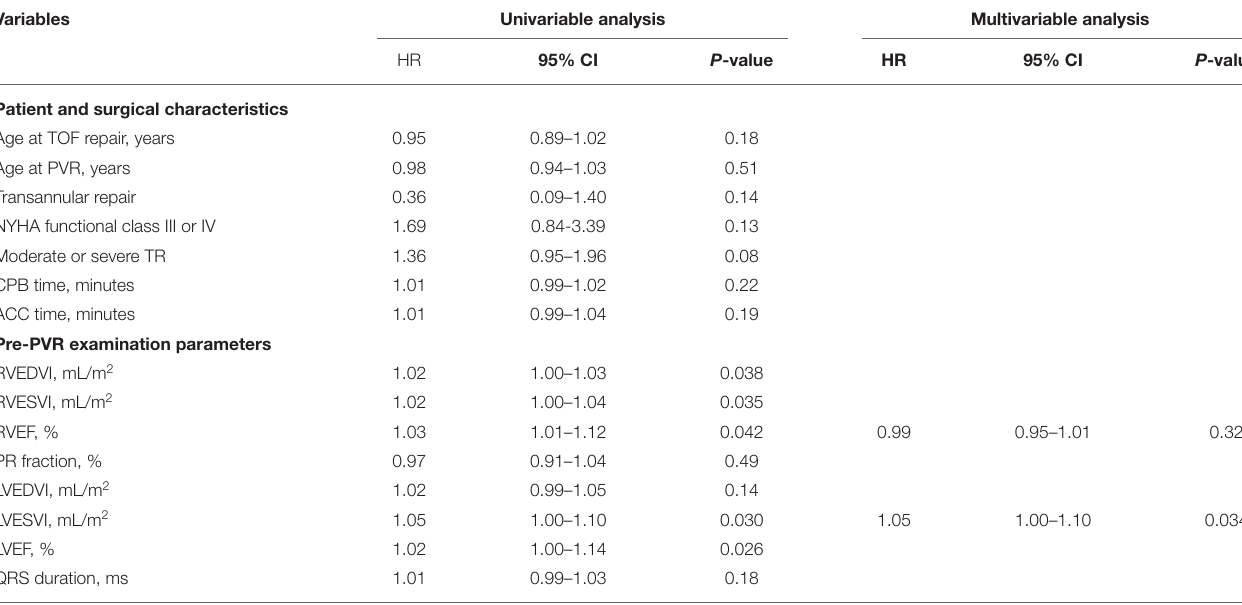
TABLE 4 | Risk factors associated with adverse clinical outcomes after